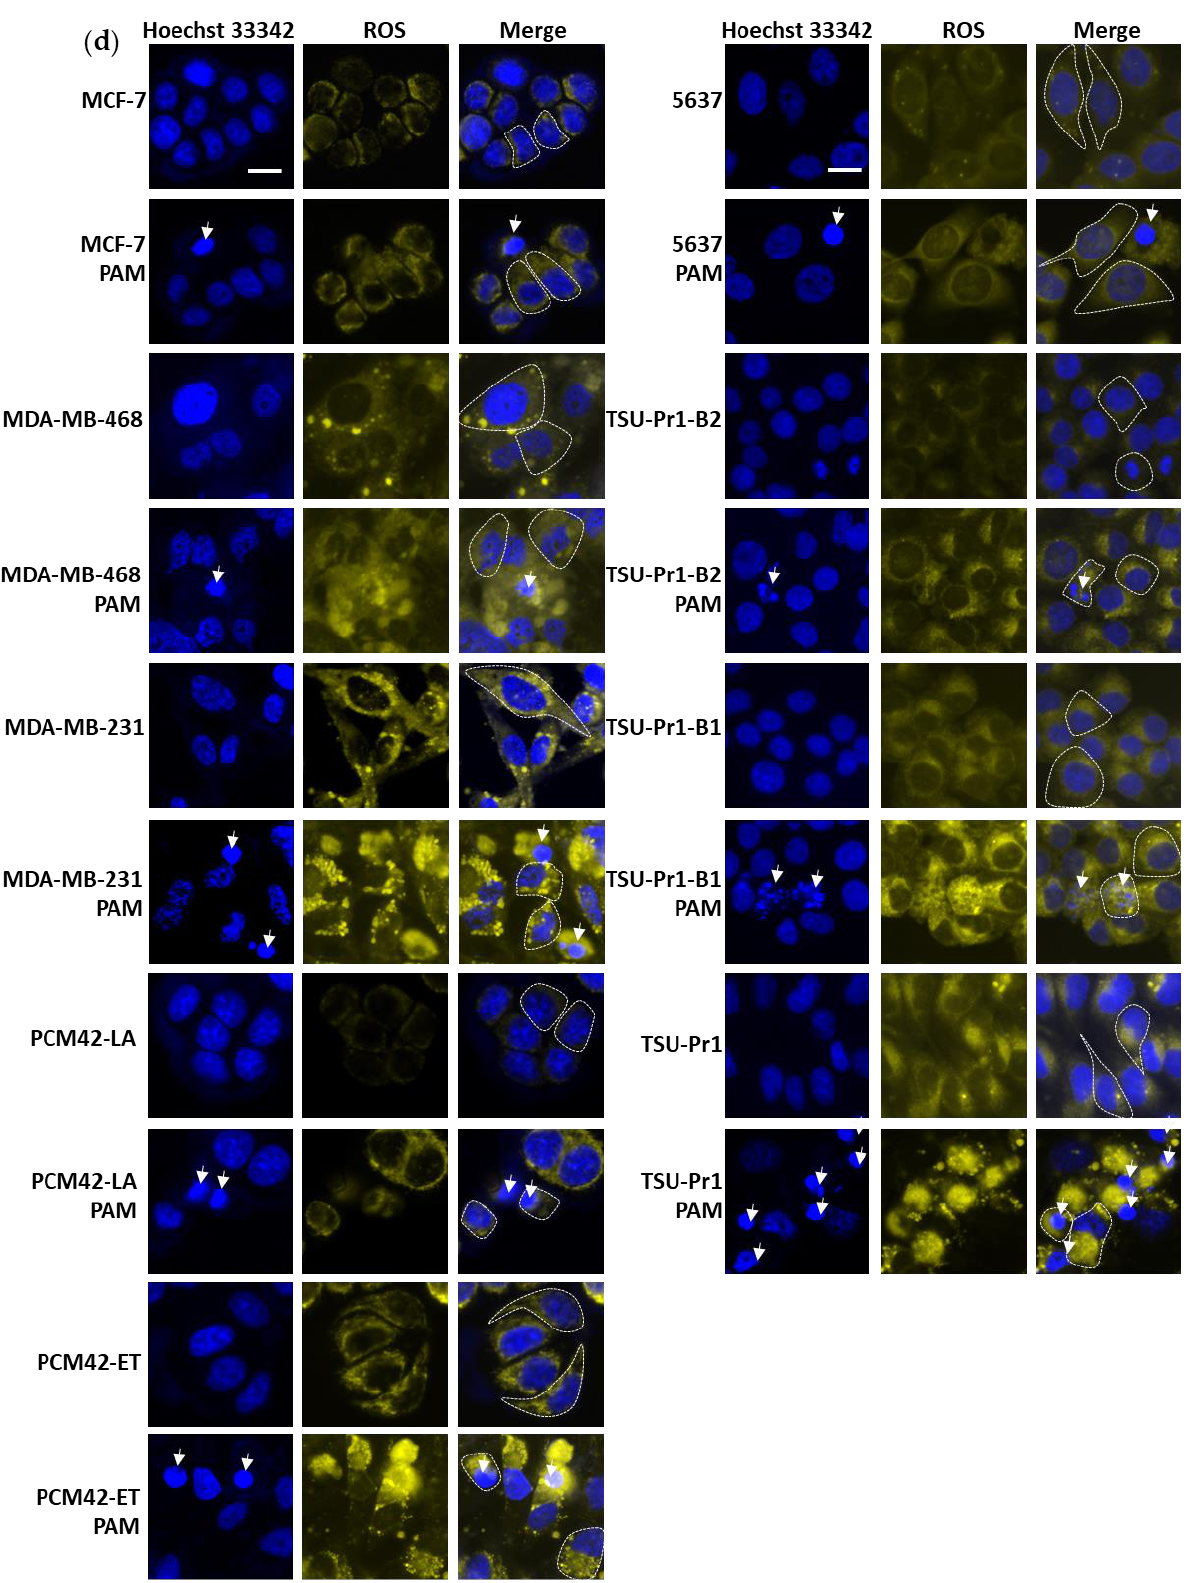
Figure 2. The effect of PAM on ROS levels in breast and bladder cancer cell lines. Breast cancer cell lines (MDA-MB-231, MDA-MB-468, MCF-7; pink) and EMT/MET cell line systems in breast (PMC42-ET/LA; grey) and bladder cancer